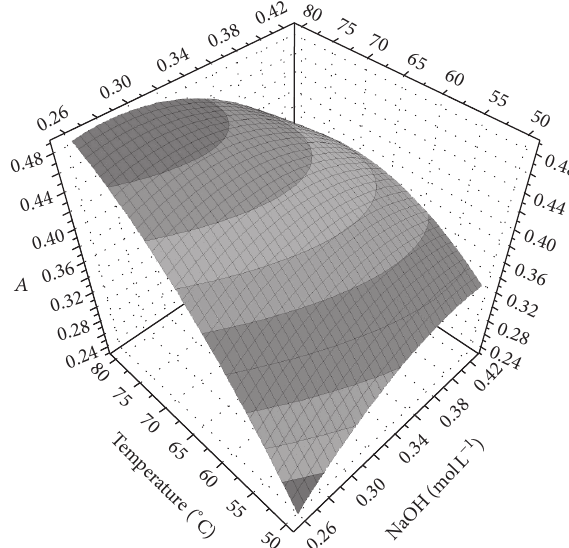
Figure 8: Graphic response surface of the circumscribing central composite design (CCC) for the AOF-KMnO 4